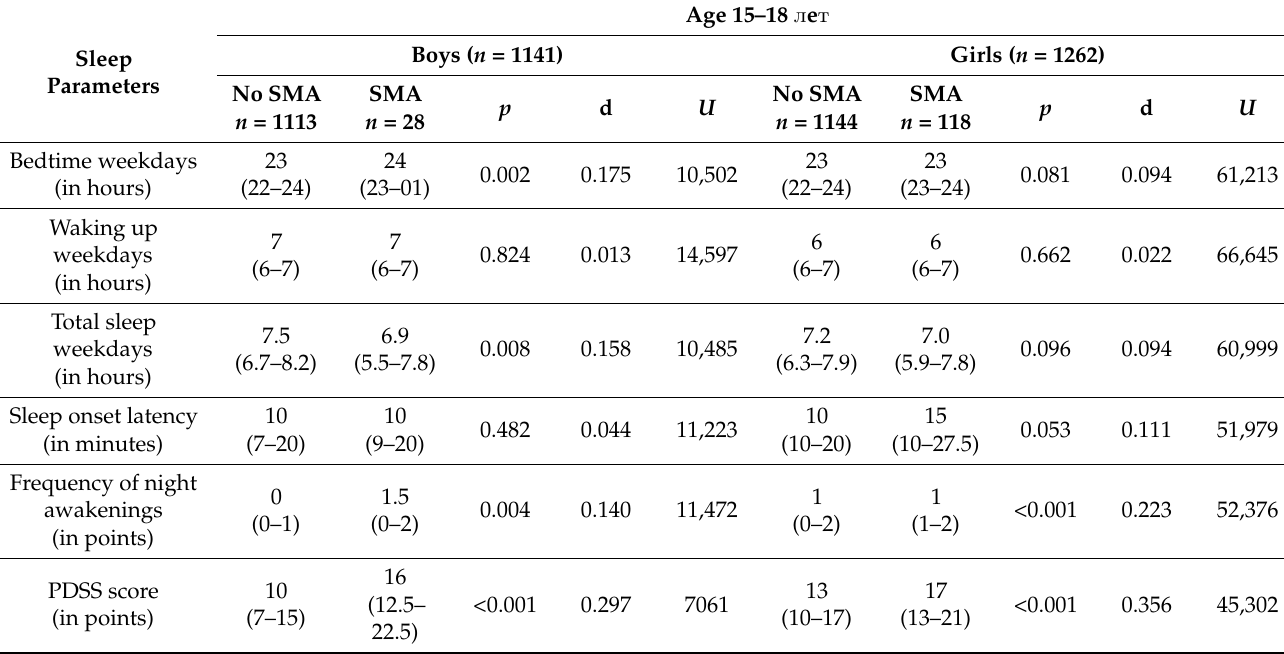
Table 8. Sleep parameters in adolescents aged 15–18 with social media addiction (SMA) verified with the Social Media Disorder Scale